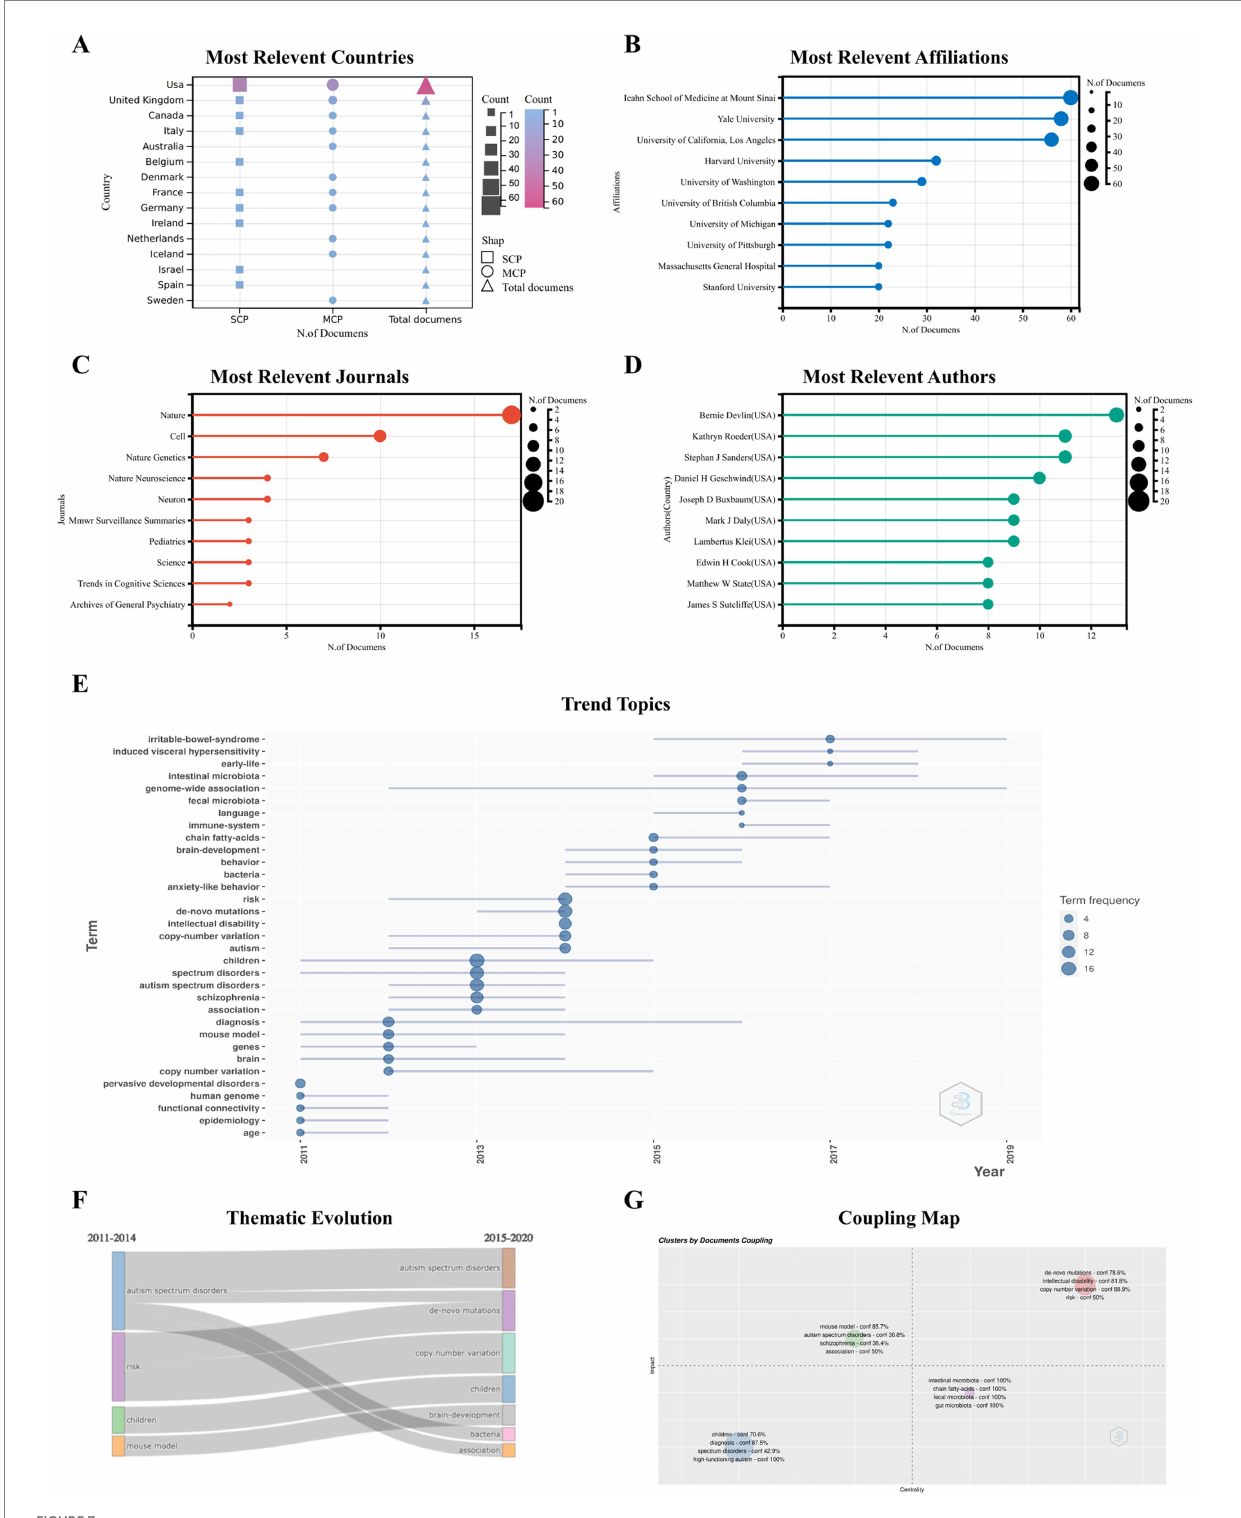
FIGURE 7 Analysis of the 100 top-cited publications Characteristics of 100 top-cited publications. The most relevant countries (A) , affiliations (B) , journals (C) and authors (D) . Trend topics (E) and thematic evolution (F) of 100 top-cited publication. Coupling Map (G) : the coupled analysis of the article, references and keywords is carried out, the centrality of the x -axis is displayed, the y -axis is the impact, and the confidence (conf%) is calculated.